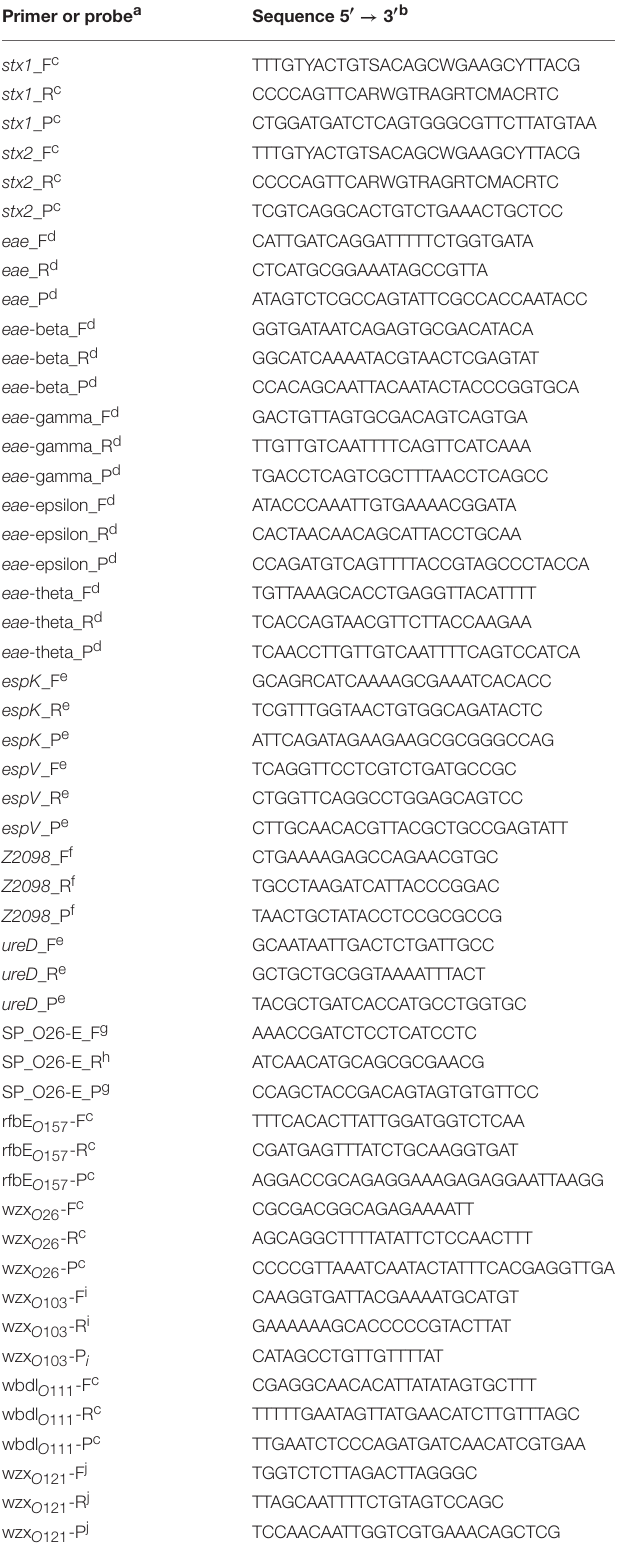
TABLE 2 | Primer and probe sequences used in this study. Primer or probe